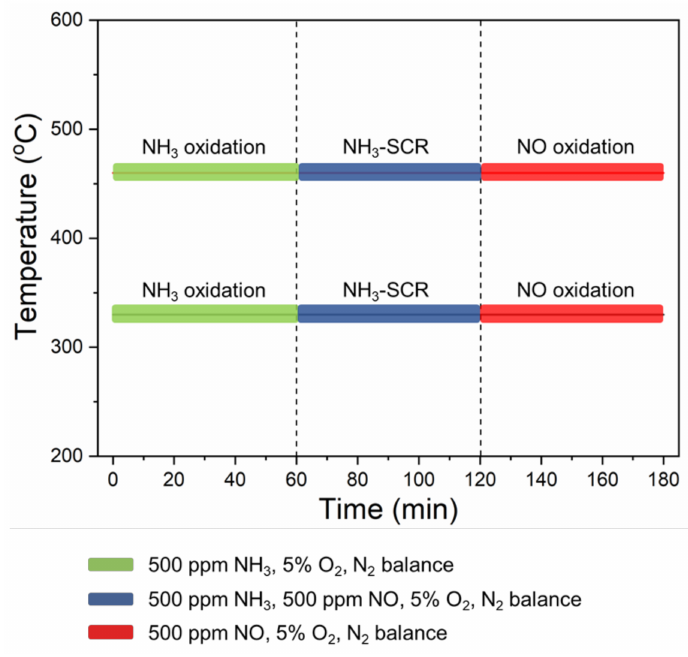
Figure 3. The procedure of the transient reactions. Both the non-selective NH 3 oxidation reaction (NSNO, R.4) and the non-selective NO x catalytic reduction reaction (NSCR, R.2) contributed to the N 2 O formation [21]. The larger content of N 2 O in the PtxCu sample than Cu-SSZ-13 (Figure 2) must be attributed to the enhancement of the NSNO and NSCR reaction rates. However, the N 2 O formation cannot be attributed to the enhancement of the non-selective NH 3 oxidation reaction (NSNO, R.4), because only a low concentration of N 2 O was formed in the NH 3 oxidation period at 330 ◦ C, as shown in Table 1. After the introduction of NO, the N 2 O concentration was significantly increased (Table 1). This indicates that the N 2 O formation was primarily attributed to the non-selective NO x catalytic reduction reaction (NSCR, R.2), which was catalyzed by Pt